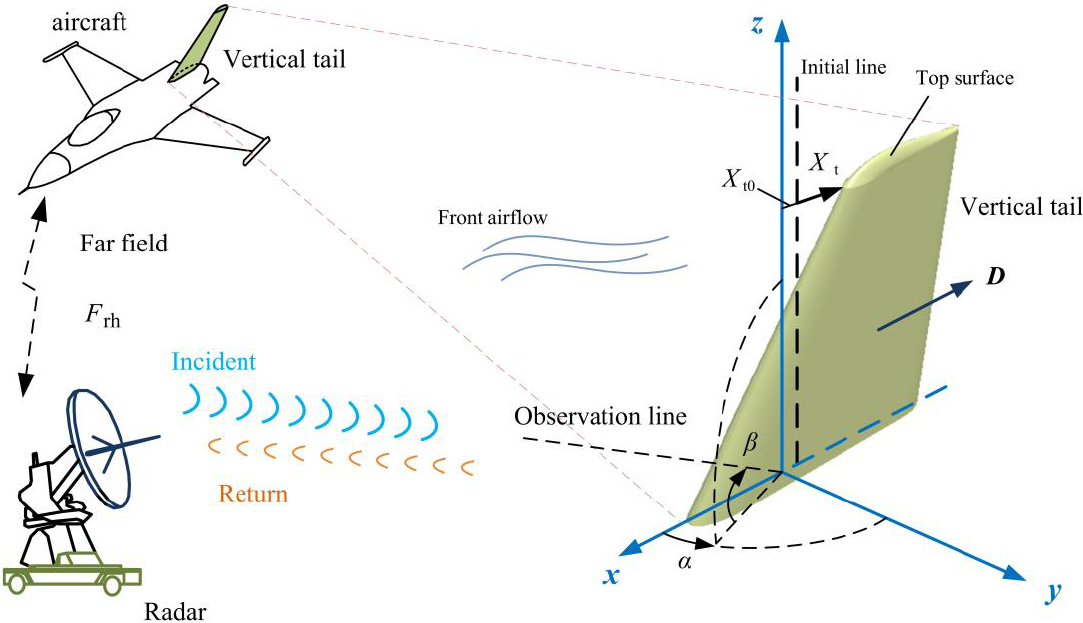
Figure 1. Schematic of aero-stealth optimization for the backward-tilt vertical tail.